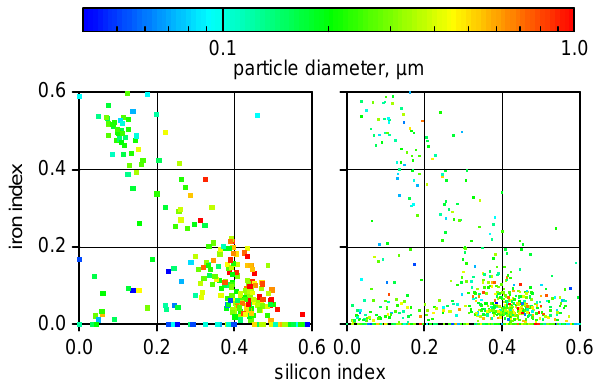
Fig. 4. Iron index versus silicon index for the Burkina Faso (left) and SAMUM B3 (right) samples. Particle diameter is coded as symbol colour. Element indices are defined as atomic ratio of the element to the sum of Na, Mg, Al, Si, P, S, Cl, K, Ca, Ti, and Fe. index 0.1 and iron index 0.5), which is more abundant in the Burkina Faso than in the SAMUM B3 sample. Apart Fig. 5. Transmission electron microscopy bright-field image of a silicate particle with grains of nanometre-sized crystallites of iron oxides (marked by white circles).